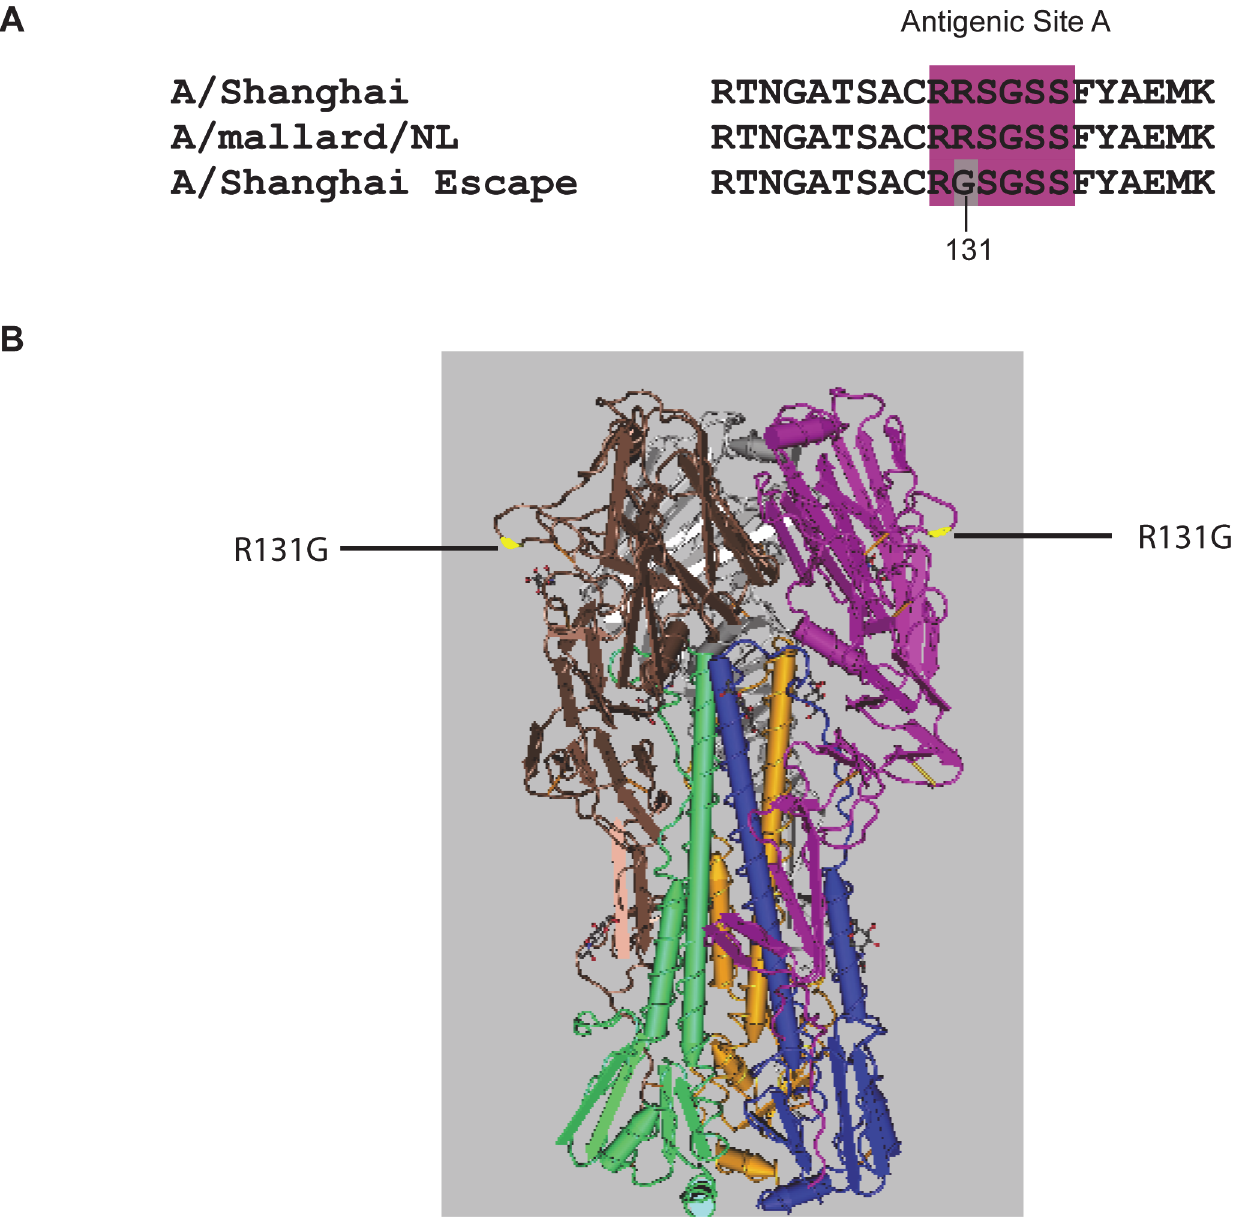
Figure 1. Location of HA amino acid changes in A/Shanghai/2/2013 escape mutants to mAb 5A6, 2C4, and 4A2. (A) HA sequence alignment of A/ Shanghai/2/2013, escape mutants selected by H7 monoclonal antibodies, and A/mallard/Netherlands/12/2000. The antigenic site A, based on the similar region for H3, is shown in color. The amino acid change identified in the escape mutants is shaded. (B) Antigenic structure of the A/Shanghai/2/2013 HA trimer and location of the R131G mutation, highlighted in yellow (PDB ID: